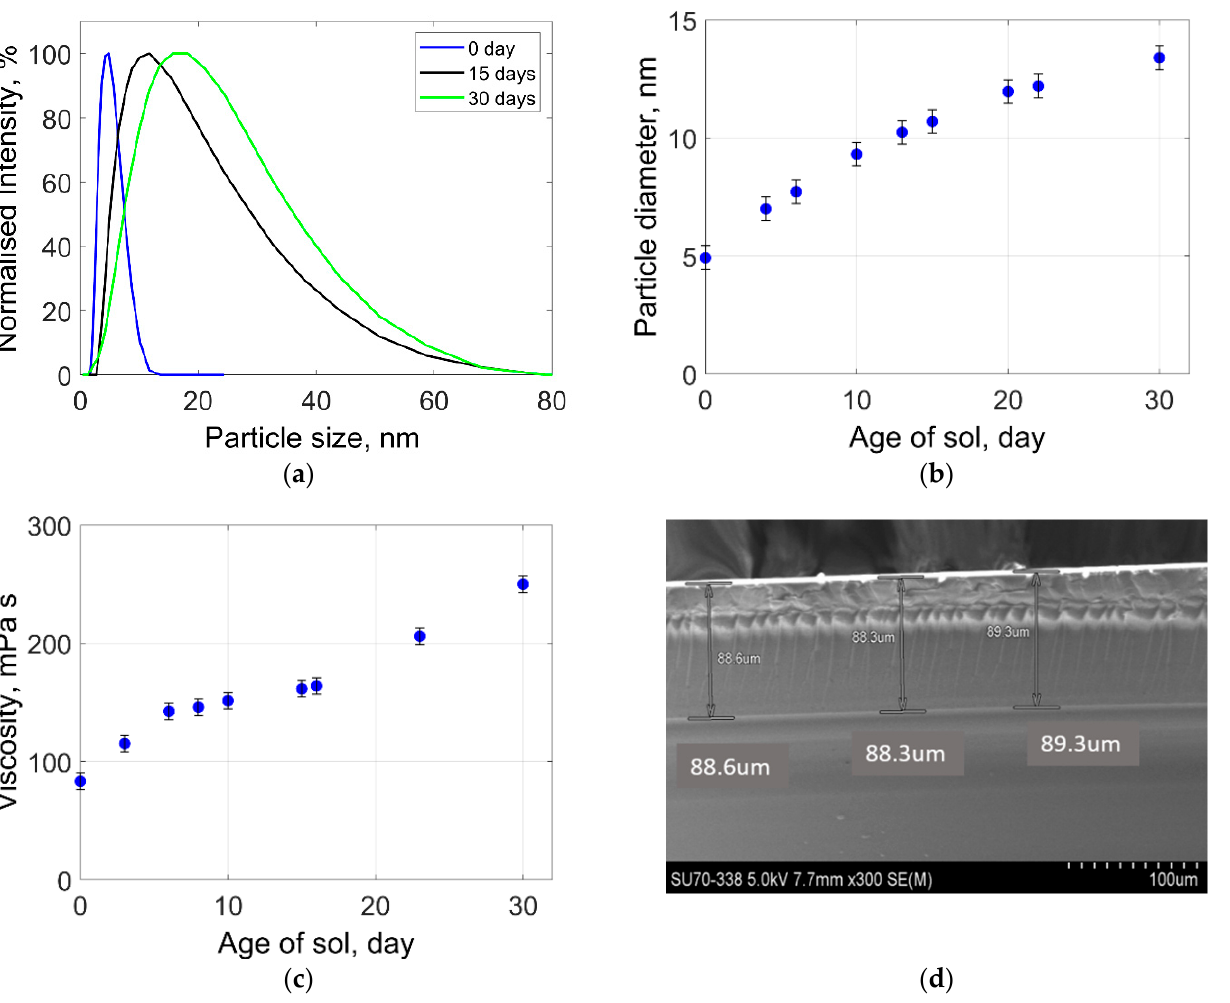
Figure 2. ( a ) Particle size distribution of the sol with age of 0, 15, and 30 days obtained by DLS analysis; ( b ) particle size diameter of the sol obtained from the peak of intensity of the size distribution curve (Figure 2a) versus the age of the sol; ( c ) dynamic viscosity of the sol with different age; ( d ) SEM image of the cross-section of PHSG layer prepared by use of sol with age of 7